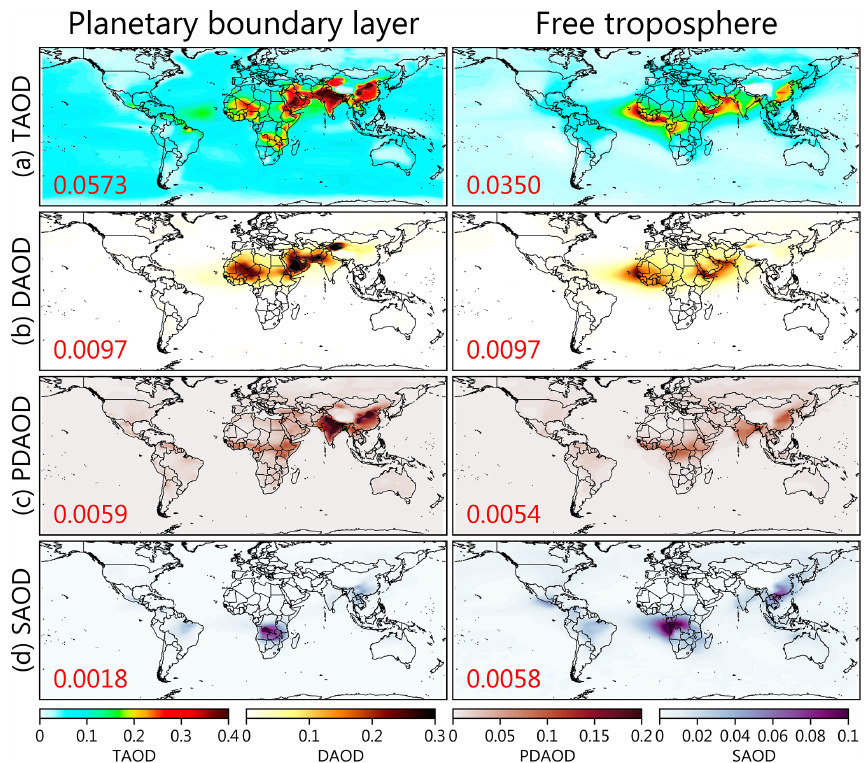
Figure 4. Spatial distributions of multi-year averaged AODs for (a) total aerosols, (b) dust, (c) PD, and (d) smoke in the planetary boundary layer (left-hand-side panels) and free troposphere (right-hand-side panels). The global average is labeled in the lower left of each